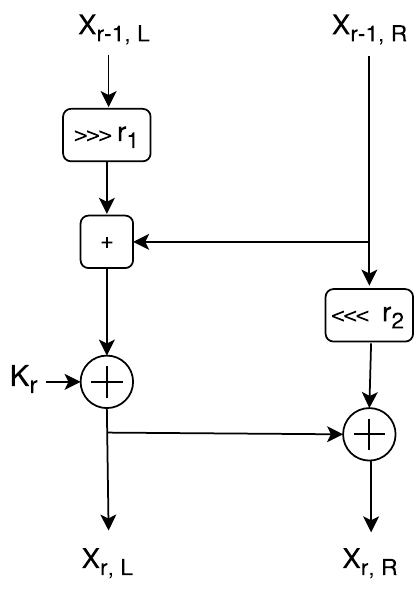
Figure 8. The round function of